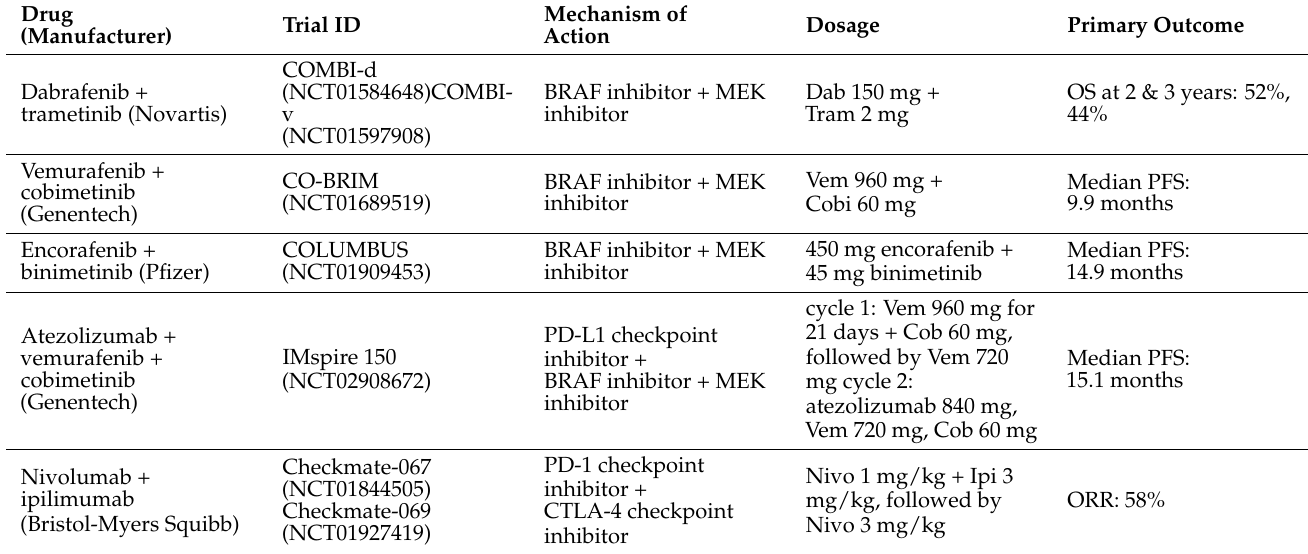
Table 2. FDA approved combination therapies used to treat stage III/IV